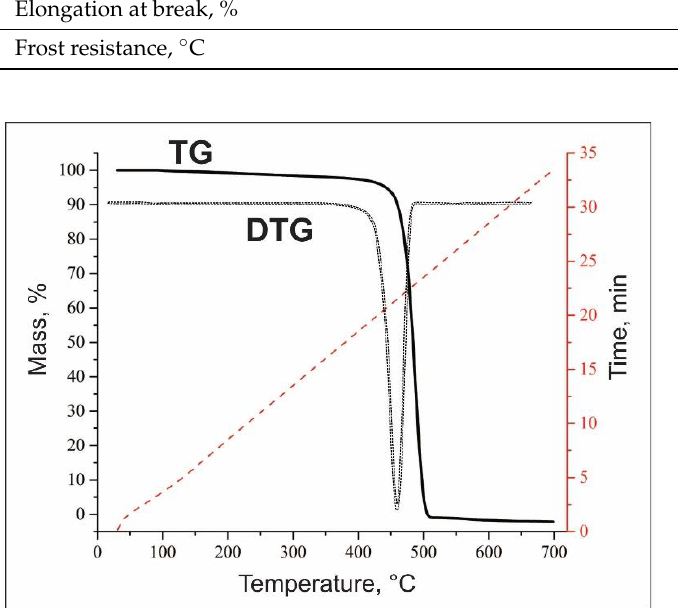
Figure 1. TGA of a plastic waste sample.